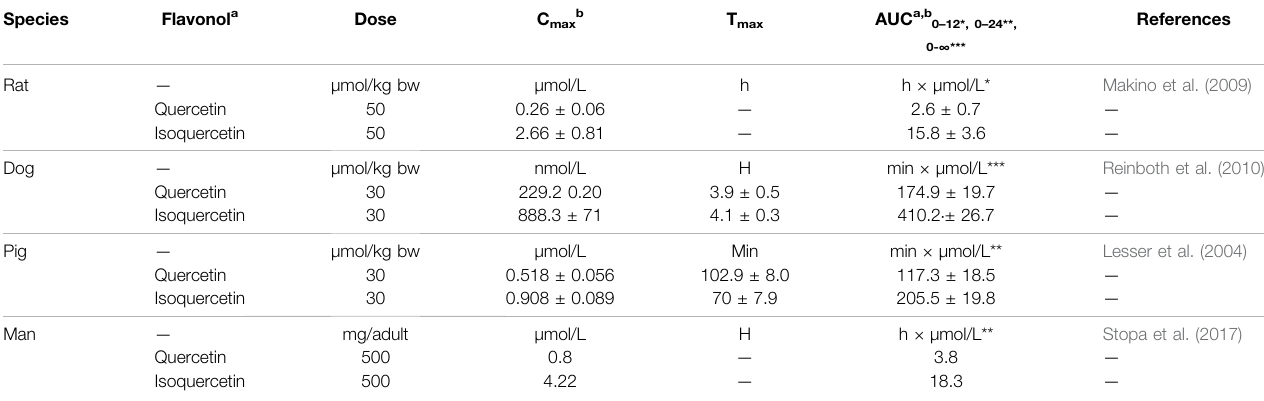
a Abbreviations: AUC, area under the curve; bw, body weight; IQC, isoquercetin; QC, quercetin aglycone. b Thequercetinformstitratedwere:forratandman,aglycone,glucuronidated,andmethylatedquercetins;forratall(Makinoetal.,2009)butmethylatedquercetins.Dataareexpresseda mean ±, standard error for rats and pigs, or standard deviation for dogs. -, not reported.